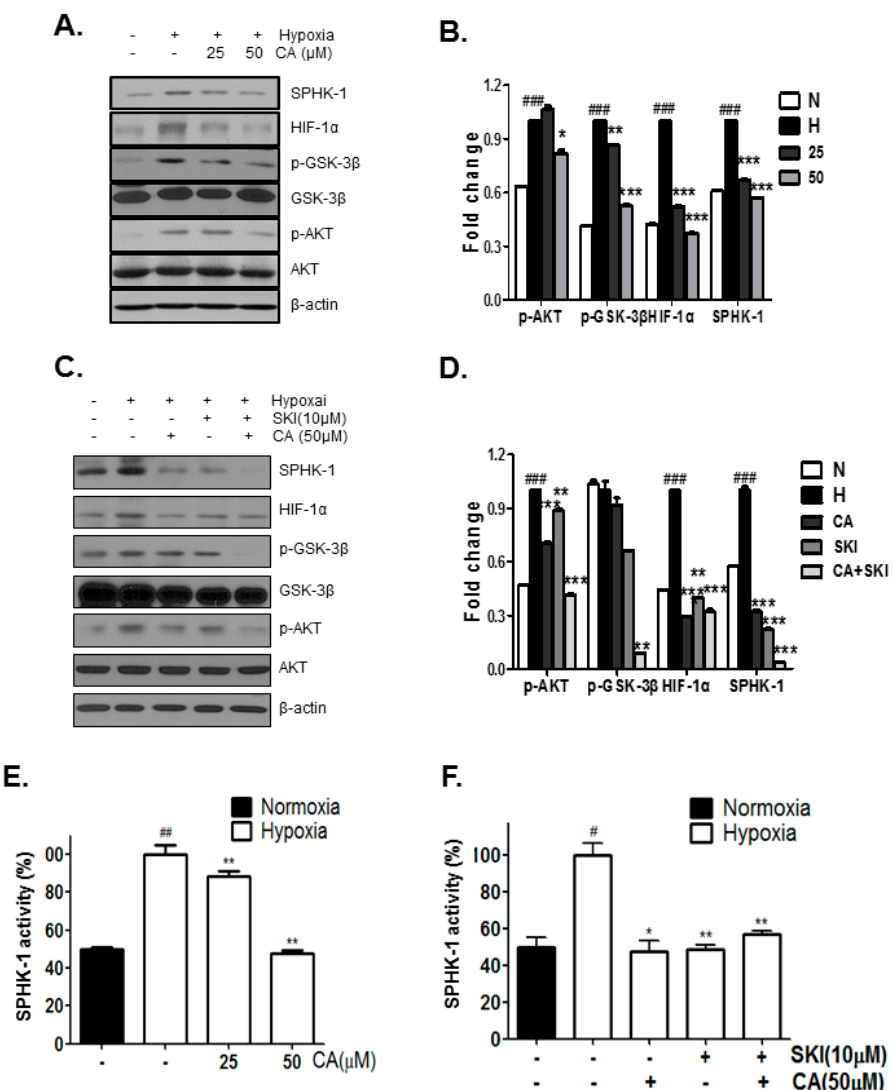
Figure 3. Effect of CA on hypoxia-induced SPHK-1 signaling in DU145 cells. DU145 cells were treated without or with CA (25 and 50 µM) under hypoxia for 4 h. Levels of phosphorylated and total AKT and GSK-3 β , SPHK-1, and HIF-1 α proteins were determined by western blot analysis. SPHK-1 activity was determined by SPHK-1 activity assay. ( A ) Levels of SPHK-1, HIF-1 α , AKT, p-AKT, GSK-3 β , p-GSK-3 β and β -actin by CA; ( B ) Quantitative protein levels are shown. The results are expressed as means ± S.D. (###) p < 0.001, compared to control under normoxia. (*) p < 0.05, (**) p < 0.01, (***) p < 0.001, compared to control under hpoxia; ( C ) Inhibitory effect of SKI on hypoxia–induced SPHK-1 signaling in DU145 cells; ( D ) Quantitative protein levels are shown. The results are expressed as means ± S.D. (###) p < 0.001, compared to control under normoxia. (**) p < 0.01, compared to control under hypoxia; ( E ) SPHK-1 activity. Data are presented as means ± S.D. (**) p < 0.01 compared to control under hypoxia. (##) p < 0.01, compared to control under normoxia; ( F ) Effect of SKI